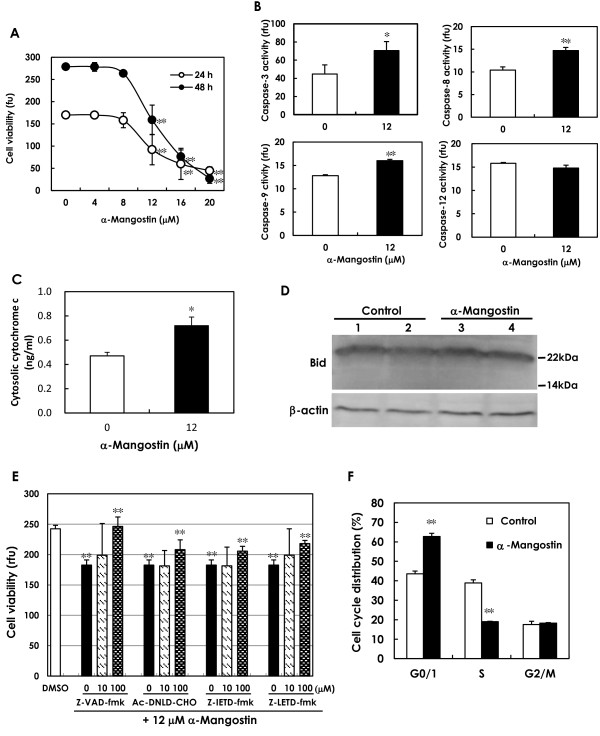
Apoptosis and cell cycle in vitro study (mouse mammary carcinoma BJMC3879luc2 cells). (A) Cell viability was significantly lower in mouse mammary carcinoma BJMC3879luc2 cells treated with more than 12 μM α-mangostin for 24 or 48 hours (**P < 0.01). Five samples from each dosage of α-mangostin were examined. The IC50 concentration was determined to be 12 μM; therefore, 12 μM α-mangostin and 24 hour-incubation was used for all in vitro studies. (B) Caspase activities were evaluated using the luminescence assay. Activities of caspase-3, caspase-8 and caspase-9, but not caspase-12, were significantly elevated in BJMC3879luc2 cells treated with 12 μM α-mangostin for 24 hours (*P < 0.05 or **P < 0.01). Six samples from the control and eight samples from α-mangostin-treated cells were used for measurement of caspase-3 activity, and three samples from each group were used for activity measurements of the other caspases. (C) Cytochrome c in the cytosolic fraction, as determined by ELISA, was significantly increased in BJMC3879luc2 cells treated with α-mangostin for 24 hours compared to control levels (*P < 0.05). Three samples each from the control and α-mangostin-treated cell cultures were examined. (D) Western blots of Bid (22 kDa) in BJMC3879luc2 cells treated with or without α-mangostin for 24 hours were similar (upper panel). Cleaved Bid (15 kDa) was not observed after α-mangostin treatment. β-Actin served as the internal control (lower panel). (E) In BJMC3879luc2 cells treated with α-mangostin for 24 hours, cell viability was significantly increased by 10 or 100 μM of the broad-spectrum caspase inhibitor z-VAD-fmk, the caspase-3 specific inhibitor Ac-DNLD-CHO, the caspase-8 specific inhibitor z-IETD-fmk, and the caspase-9 specific inhibitor z-LETD-fmk (**P < 0.01). (F) Cell-cycle analysis showed that α-mangostin induced arrest in the G1-phase and inhibition of cells entering the S-phase in metastatic mouse mammary carcinoma BJMC3879luc2 cells (**P < 0.01). Data are presented as mean ± SD. Ac: acetyl; CHO: aldehyde; ELISA: enzyme-linked immunosorbent assay; fmk: fluoromethyl ketone; z: N-benzyloxycarbonyl.